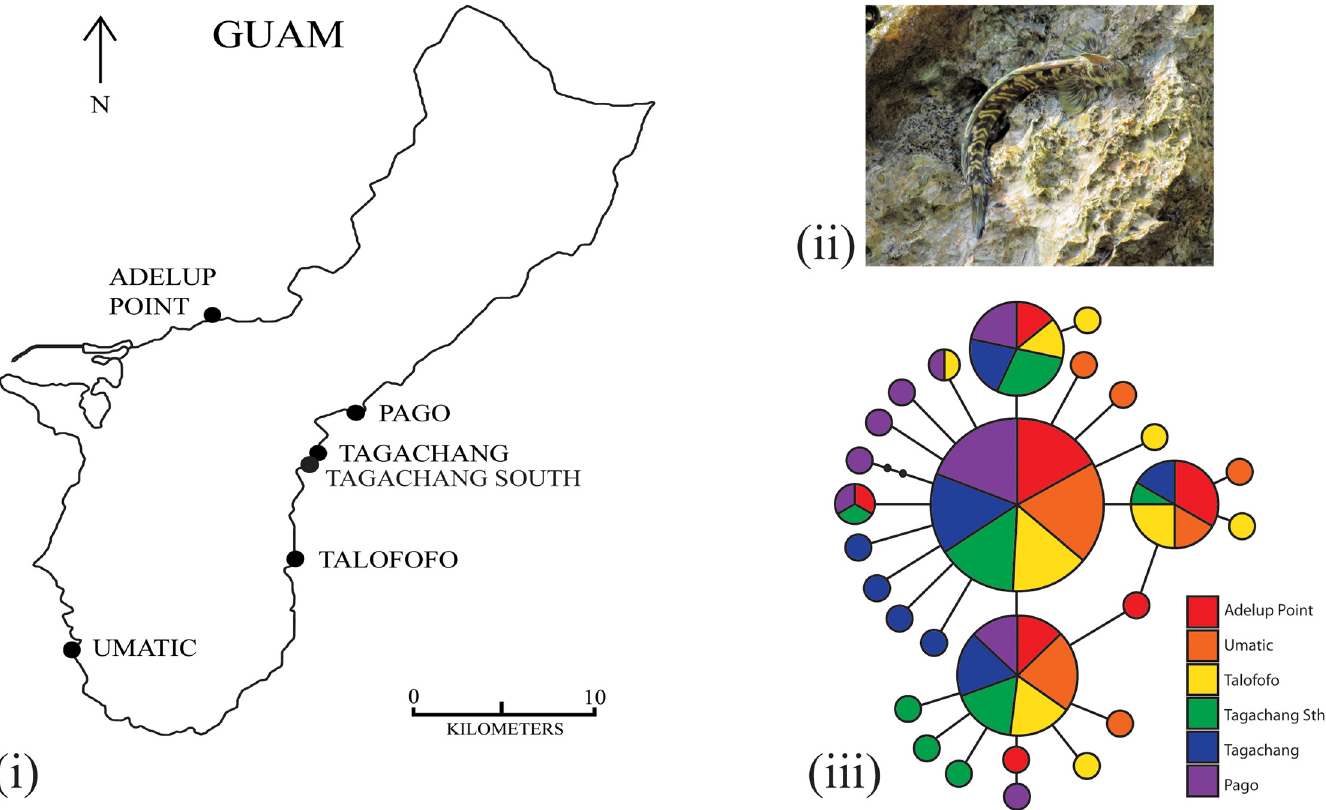
Fig 2. Sampling localities and haplotype network. The (i) sampling localities of Alticus arnoldorum around the island of Guam, site abbreviations as in Table 1, (ii) A . arnoldorum (photo G Cooke), and (iii) results from the haplotype network based on 120 mtDNA ATPase 6 and 8 sequences. Each circle denotes a unique haplotype, the area of the circle is proportional to its frequency in the sample, and the shade of the circle represents its sampling